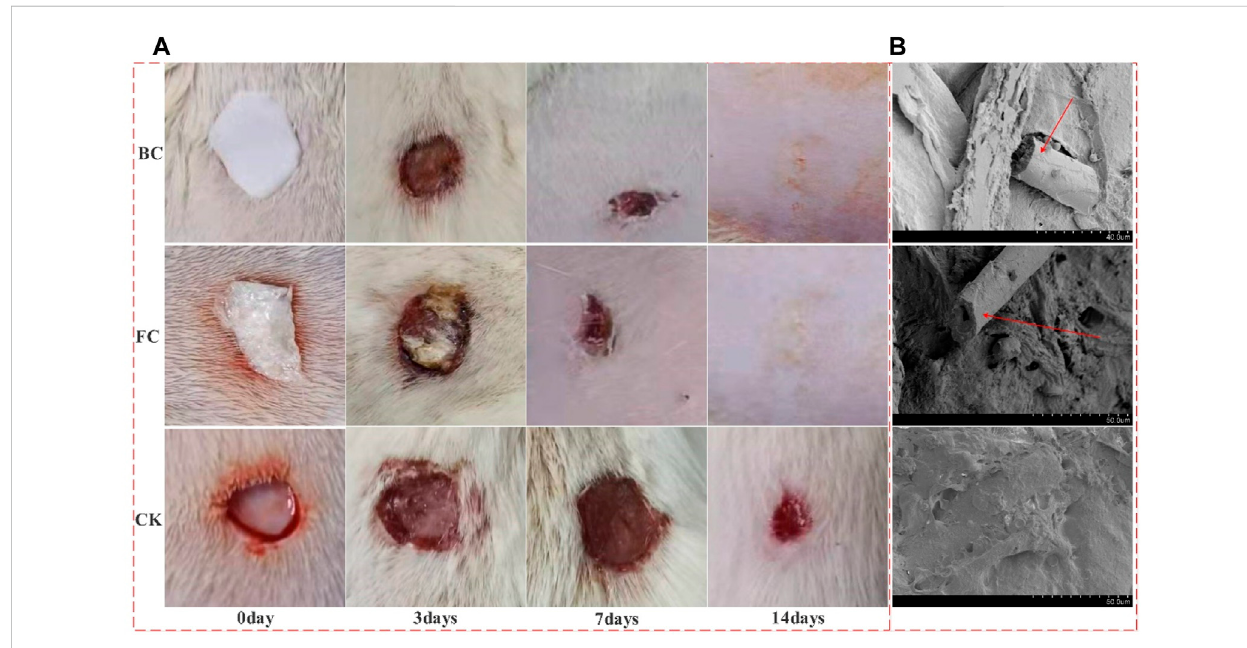
FIGURE 2 The different stages of wound healing and Vascular ingrowth. (A) Wound healing results; (B) Vascular ingrowth in the two collagen groups and self- healing group 24 h after surgery; BC: Bovine collagen sponge; FC: Fish collagen sponge; CK: self-healing group; The red arrow in the electron microscope image shows the